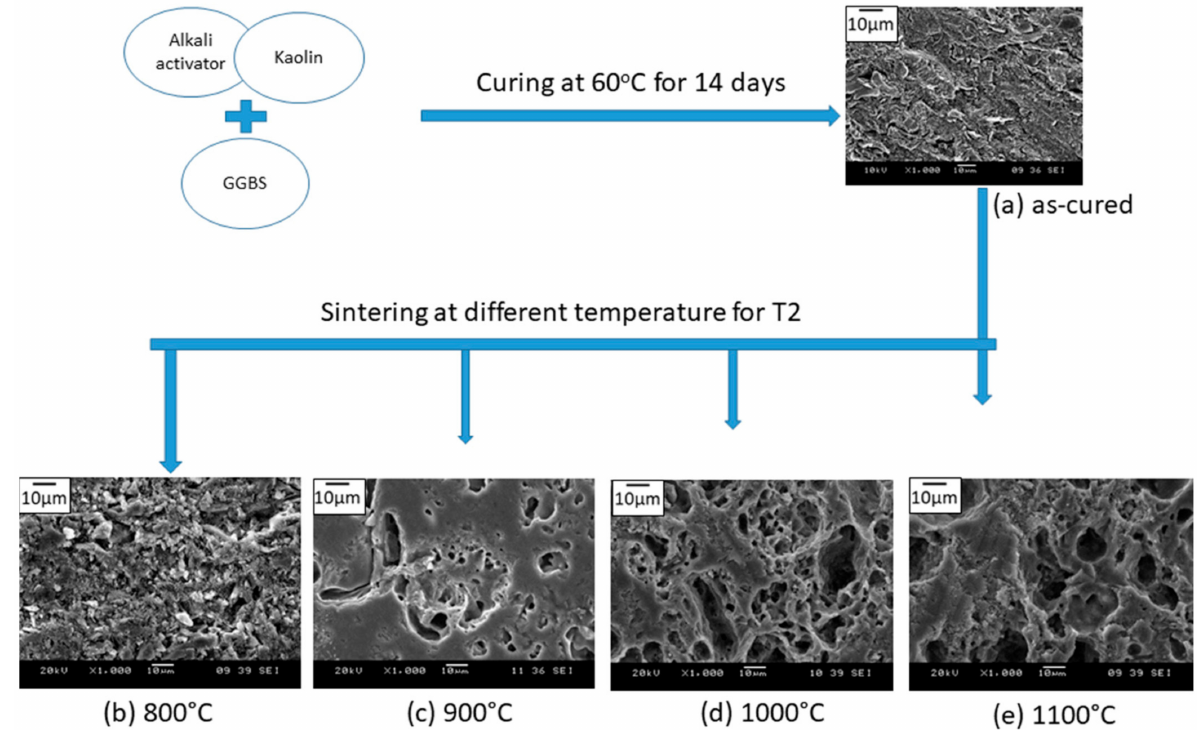
Figure 6. Microstructural evolution of sintered kaolin–GGBS geopolymer at different sintering temperatures with magnifi- cation 1000 × : ( a ) as-cured, ( b ) 800 ◦ C, ( c ) 900 ◦ C, ( d ) 1000 ◦ C, and ( e ) 1100 ◦